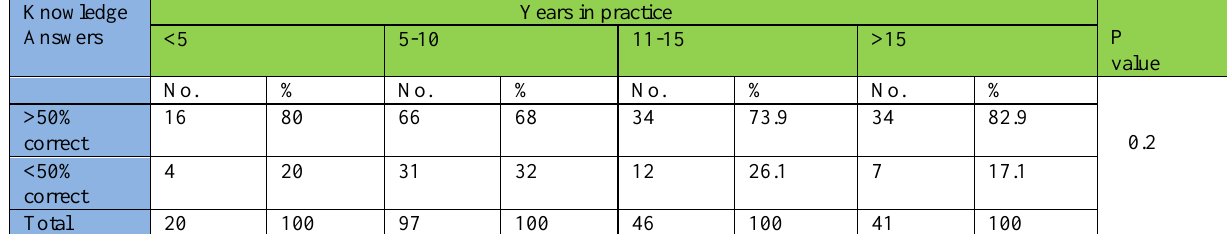
Table.4 relationships between knowledge category and years in